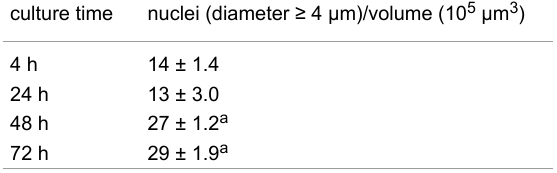
Table 1: Viability of PCLS determined by live/dead staining at 4, 24, 48, and 72 h after preparation of PCLS. culture time